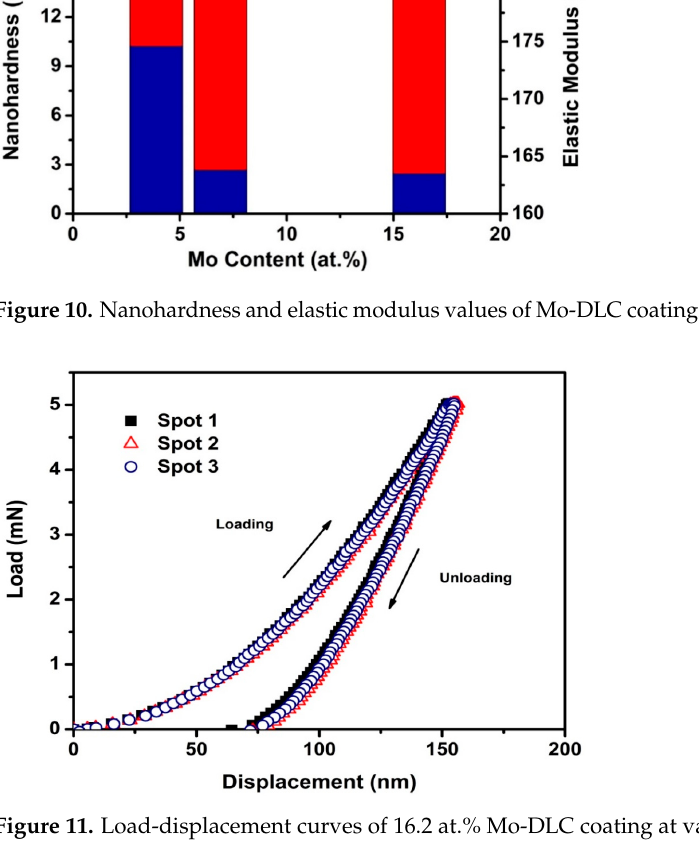
Figure 11. Load-displacement curves of 16.2 at.% Mo-DLC coating at various